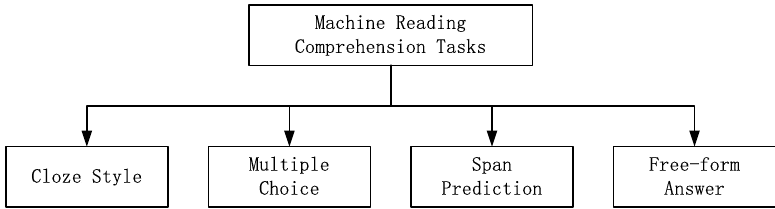
Figure 6. Existing classification method of machine reading comprehension